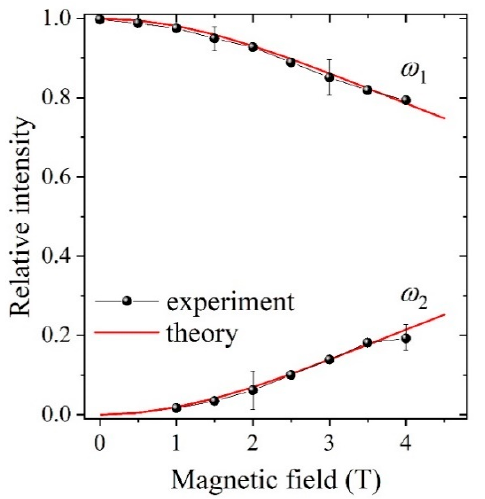
Figure 2. Measured (black symbols) and fitted by Equation (1) (red dashed line) π -polarized far- infrared reflection spectra of PrFe 3 (BO 3 ) 4 at several values of the external magnetic field B ∥ c at T = 1.5 K. Thin arrows point to the two quasi-electronic branches below B SF ≈ 4.5 T. Above B SF , they convert into a single quasi-electronic mode (indicated by a bold arrow).